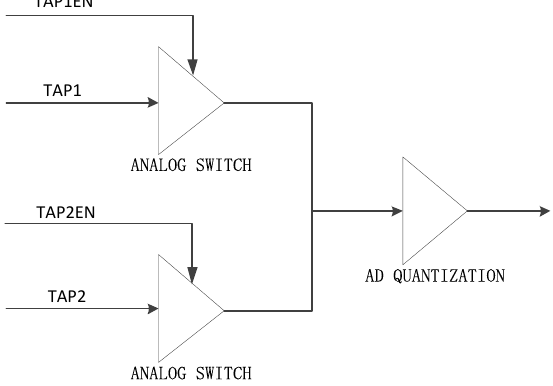
Figure 5. Schematic diagram of analog merging hardware Fig.5 is the schematic diagram of analog merging hardware. In